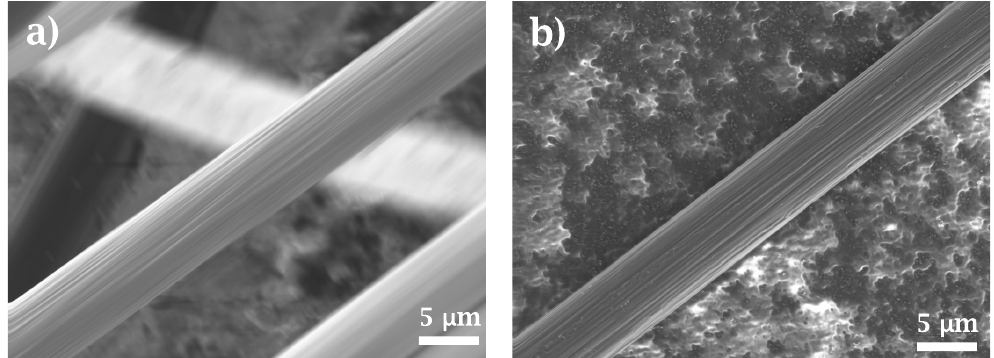
Figure 6. SEM images for ( a ) untreated ( 0-CFs ) and ( b ) treated fibers ( I-CFs ). Surface roughness is partially masked by the sizing agent in the case of untreated fibers.